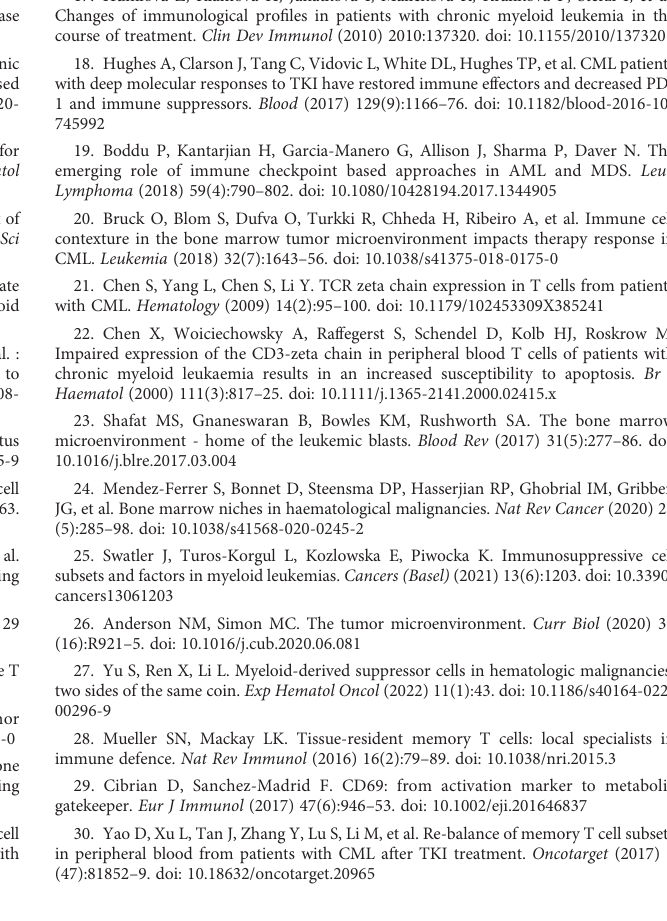
SUPPLEMENTARY FIGURE 1 CD4 + or CD8 + T N and T CM cells from the PB of DN-CML patients have a lower percentage of the activation markers CD38 and HLA-DR, and this is further decreased in TKI-F patients. The frequency of CD38, CD69, and HLA-DR on CD4 + T N (A) ,CD4 + T CM (B) ,CD8 + T N (C) andCD8 + T CM (D) inthePBofHIs(PB,n = 12, BM, n = 8) and DN-CML (PB, n = 12, BM, n = 8), TKI-F (PB, n = 9, BM, n = 6) pre-MMR (CD4, n = 9, CD8, n = 9), and MMR (CD4, n = 8, CD8, n = 8) patients. The P values shown are from the Mann-Whitney U test between groups. Signi fi cance is indicated as *, P < 0.05 in red. SUPPLEMENTARY FIGURE 2 AdecreasedlevelofHLA-DR + CD8 + T CM cellsexistsinallCMLgroups,andTKI-F patients have increased expression of the exhaustion marker TIGIT on BM CD8 + T EMRA cells. The frequency of CD38, CD69, HLA-DR, CD57, CD28, BTLA, TIGIT, and PD-1 in CD8 + T cells (A) , CD8 + T N (B) , CD8 + T CM (C) , CD8 + T EM and CD8 + T EMRA among HIs (n = 8) and DN-CML (n = 11), TKI-F (n = 6) and MR (n = 6) patients. The P values shown are derived from the Mann-Whitney U test between